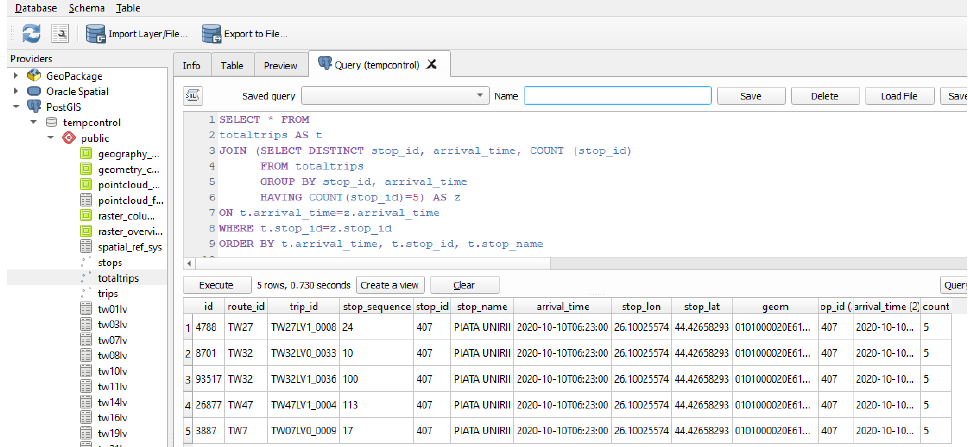
Figure 12. Number of cases of 5 trams reaching the same station at the same time. By modifying the arrival time from the schedule database and by repeated iterations, headway optimization was achieved. For instance, we chose to modify, by 1 min delay, the tramline number 25 schedule, which appeared as a third vehicle at stop_id 122, to- gether with lines 8 and 11 (Figure 13). It can be observed that, when running the algorithm with the new time values, lines 8 and 11, at the same stop_id and arrival_time, appear in cases where two vehicles arrive at the same station at the same time (Figure 14). The iter- ation was repeated again after altering the schedules of the remaining tramlines.